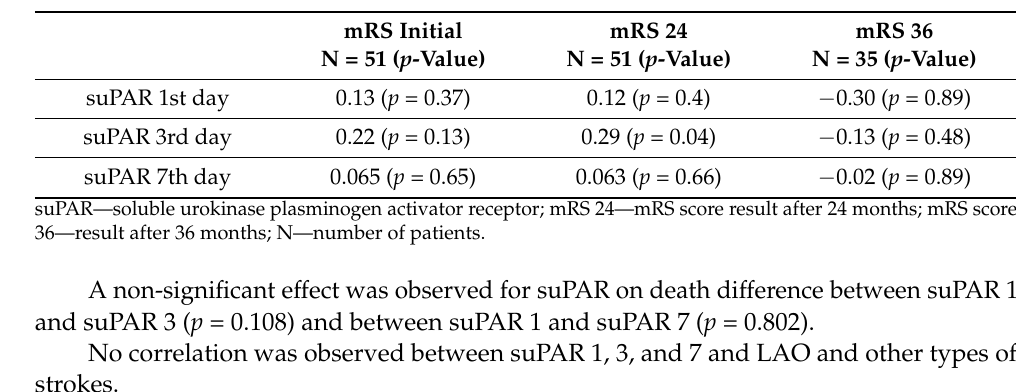
Table 3. suPAR concentration correlation with disability scales, Pearson coefficient test r ( p